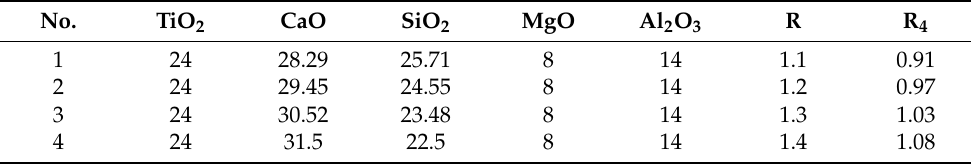
Table 2. The compositions of the TiO 2 -CaO-SiO 2 -Al 2 O 3 -MgO slag (wt.%). No. TiO 2 CaO SiO 2 MgO Al 2 O